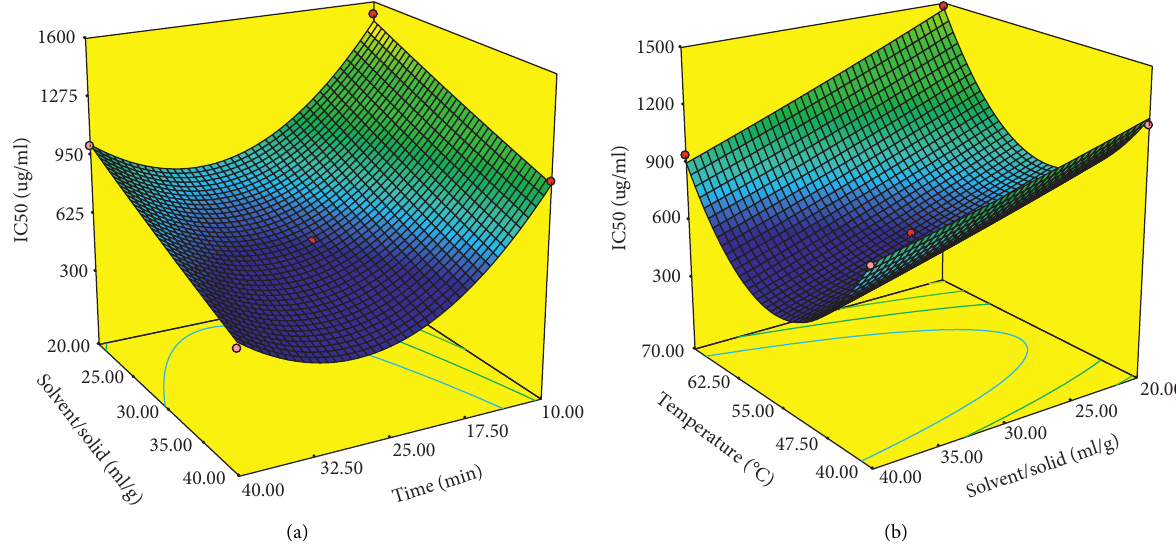
Figure 5: Response surface for the effect of (a) sonication time and water/solid ratio (sonication temperature � 55 ° C) and (b) water/solid ratio and sonication temperature (sonication time � 25 ° C) on the antioxidant activity of the